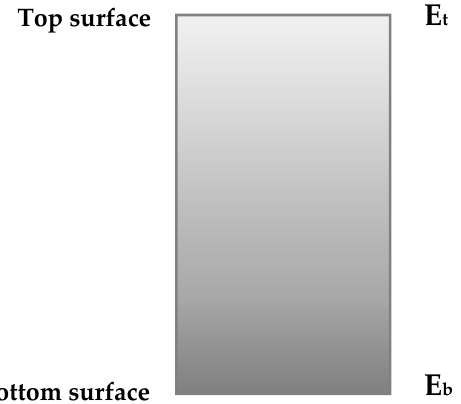
Figure 1. Example of dual-phase functional gradient material (FGM) mixture, with variation in one direction.